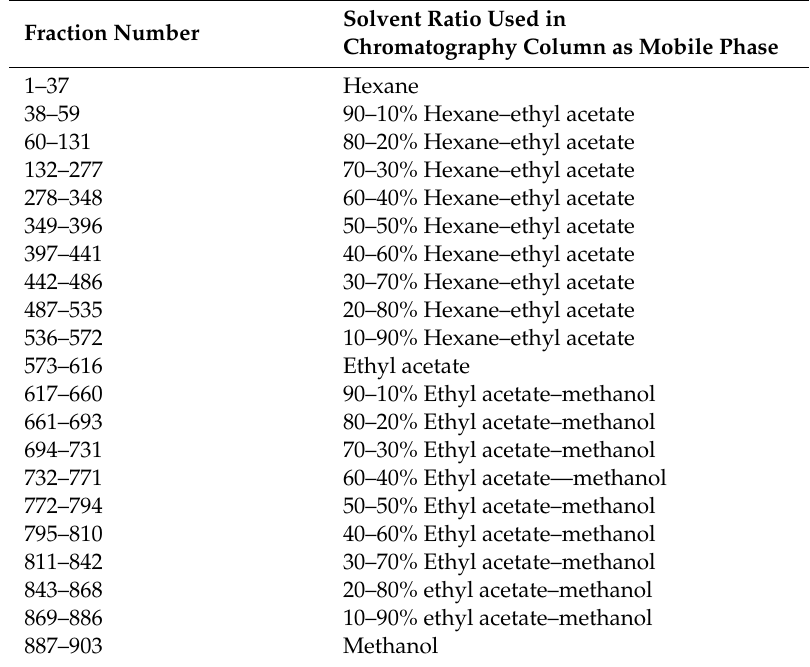
Table 1. Chromatography fractions obtained from Hibiscus sabdari ff a calyx acetonic extract.